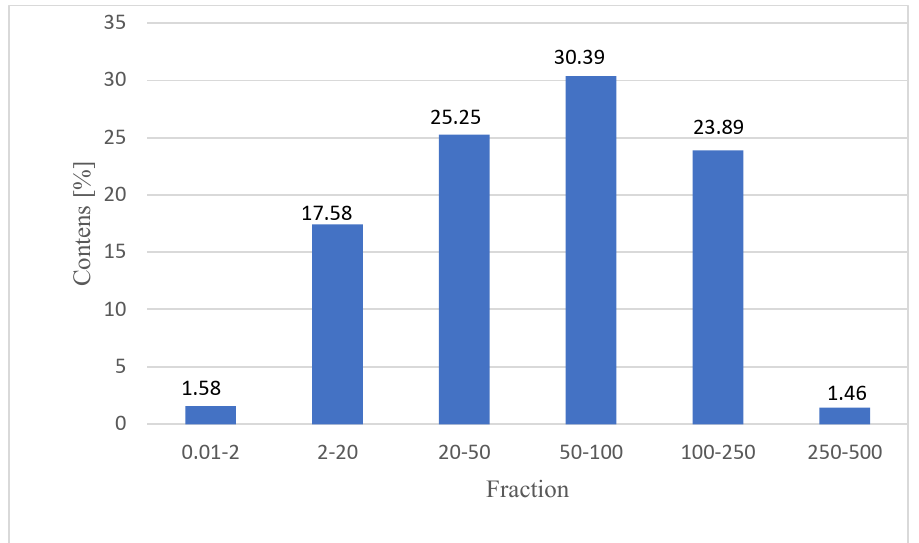
Figure 5. The SEM image of the researched ash from Kraków includes an EVS analysis: ( A ) ash microstructure; ( B ) ash microstructure; ( C ) the oxide composition of the ash.